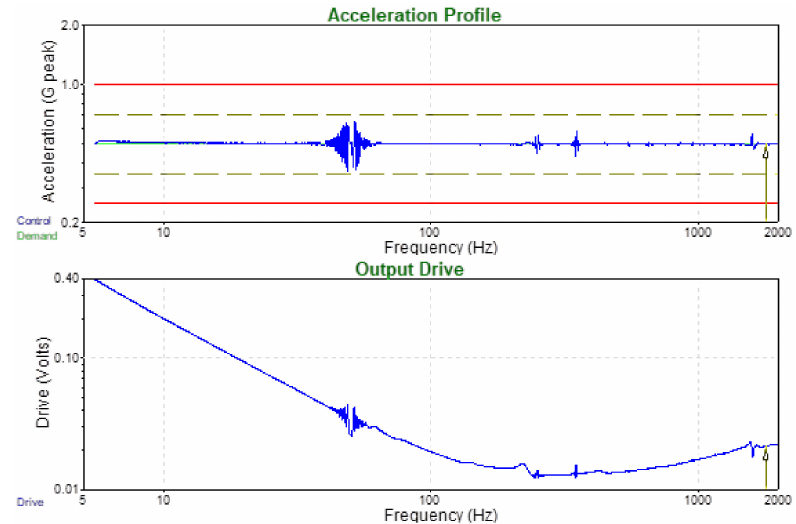
Figure 14. Acceleration profile and Output drive for the applied sine